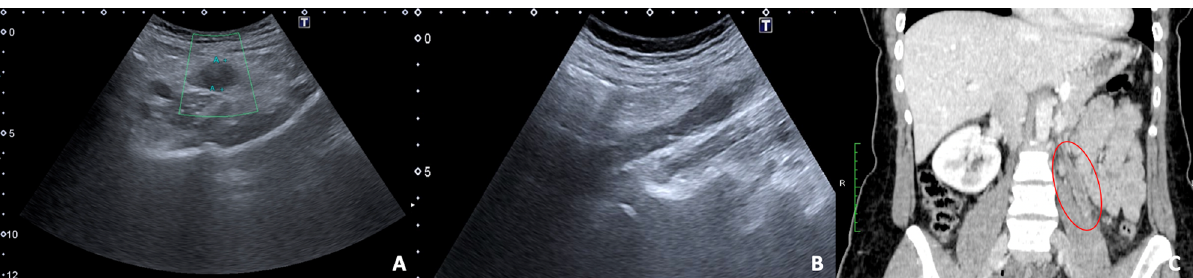
Figure 13. US and CT examinations of a pregnant woman who suffered from left pelvic pain before delivery. US B-mode scans of the left ovarian vein in axial ( A ) and longitudinal ( B ) views before delivery show the ovarian vein as a tubular structure with heterogeneous hypoechoic echotexture, located superiorly to the ovary and anteriorly to the psoas muscle. ( C ) Contrast-enhanced CT coronal image was performed after delivery and confirmed the left gonadic vein thrombosis (red circle).